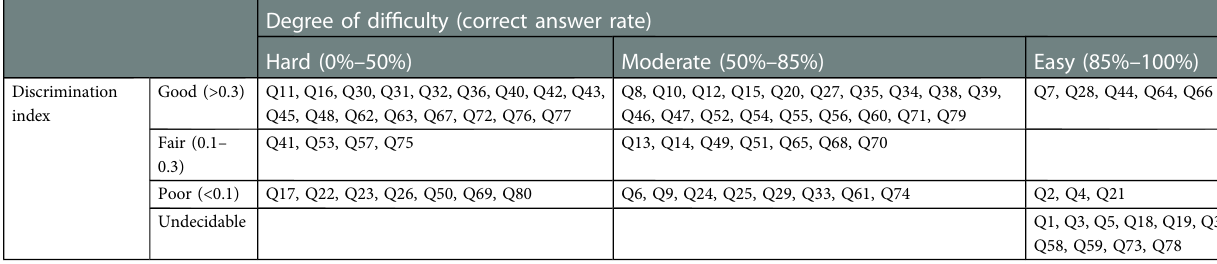
TABLE 2 Degree of dif fi culty and discrimination index of the questions (Study 1).